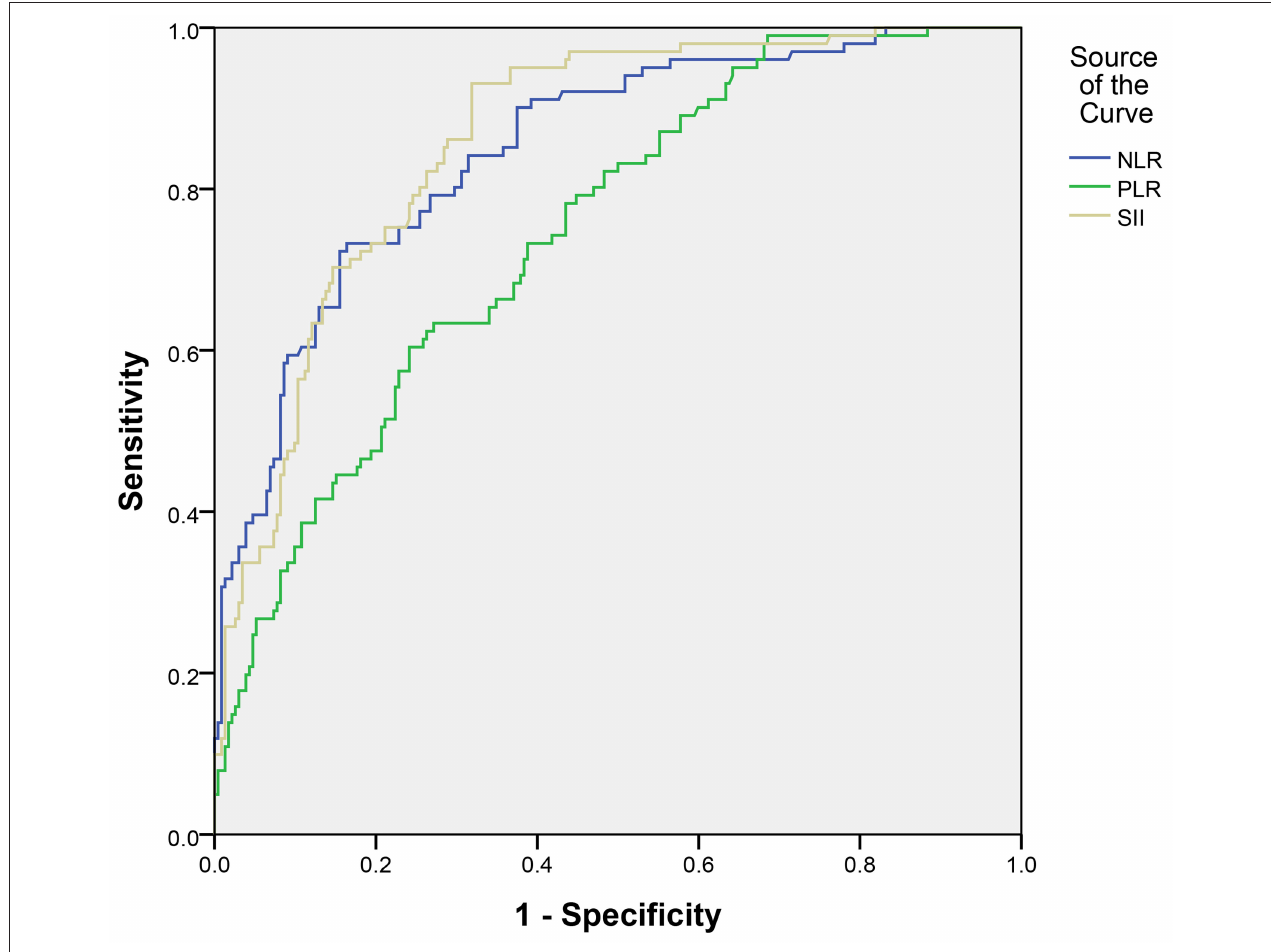
FIGURE 2 | Discriminative ability of the SII, NLR, and PLR for DCI. SII, systemic immune-inflammation index; NLR, neutrophil-lymphocyte ratio; PLR, platelet-lymphocyte ratio.